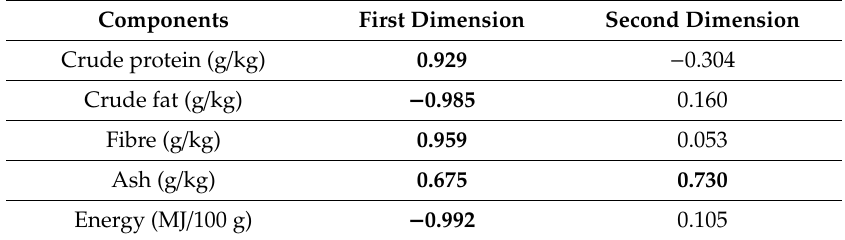
Table 4. Results of the principal component analysis, and correlation coe ffi cients by variables and dimensions, characterising the nutrient concentration of the larvae.